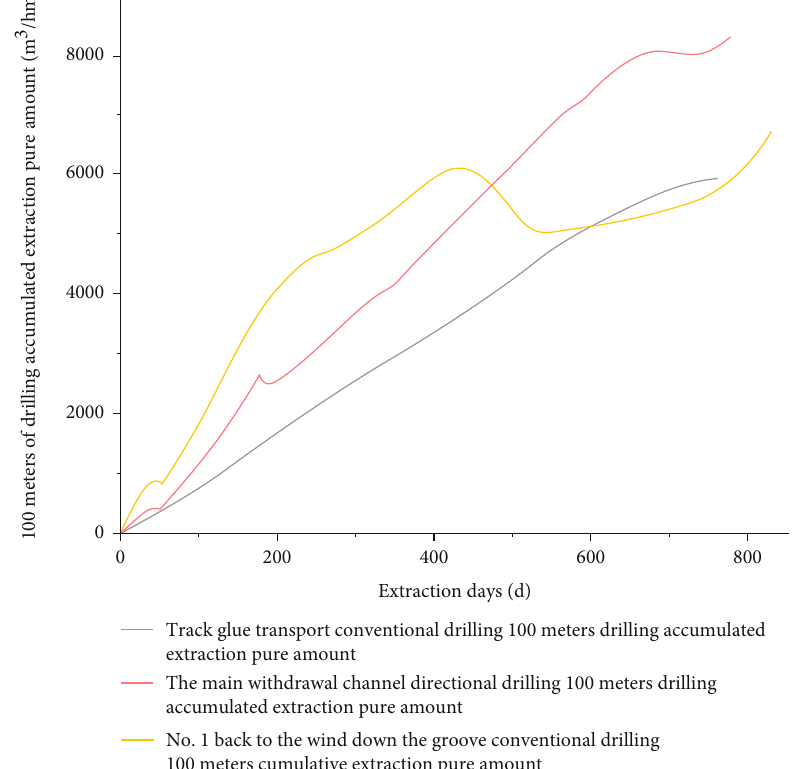
Figure 11: Comparison of cumulative pure extraction volume between directional drilling and conventional drilling on the working face